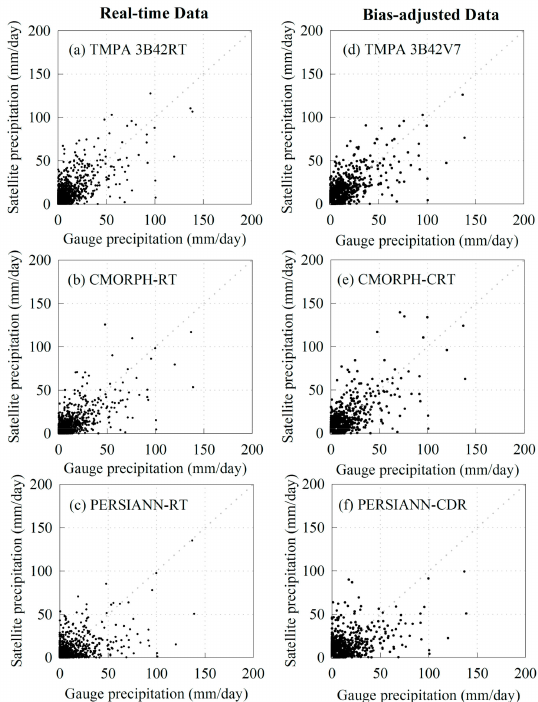
Figure 2. Scatterplots of the basin average daily precipitation between SPPs and rain gauge observations for Xixian Basin: ( a ) TMPA 3B42RT; ( b ) CMORPH-RT; ( c ) PERSIANN-RT; ( d ) TMPA 3B42V7; ( e ) CMORPH-CRT; ( f )